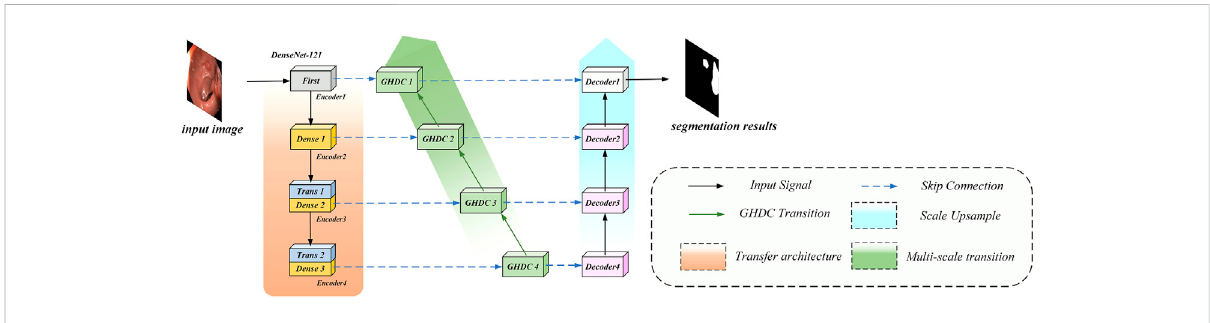
FIGURE 1 The overview of our proposed